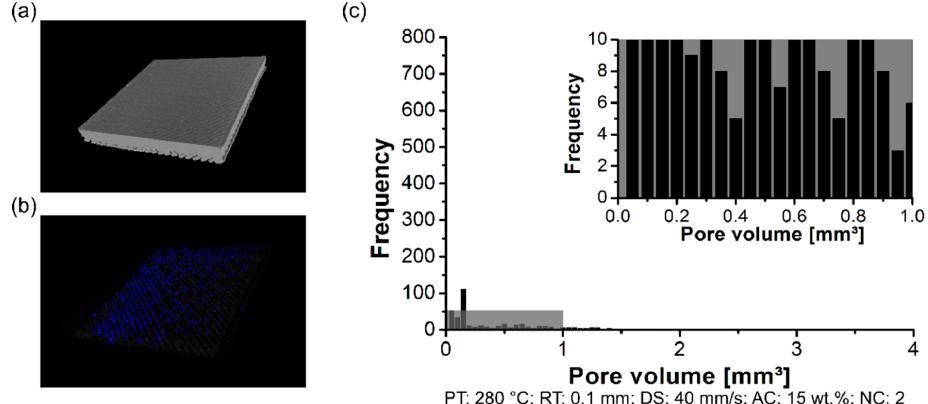
Figure 11. Pore distribution on the 3D ‐ printed ABS for condition four (PT: 280 °C, RT: 0.1 mm, DS: 40 mm/s, AC: 15 wt.%, and NC: 2): ( a ) scanned volume, ( b ) pores distribution, and ( c ) pore volume histogram.